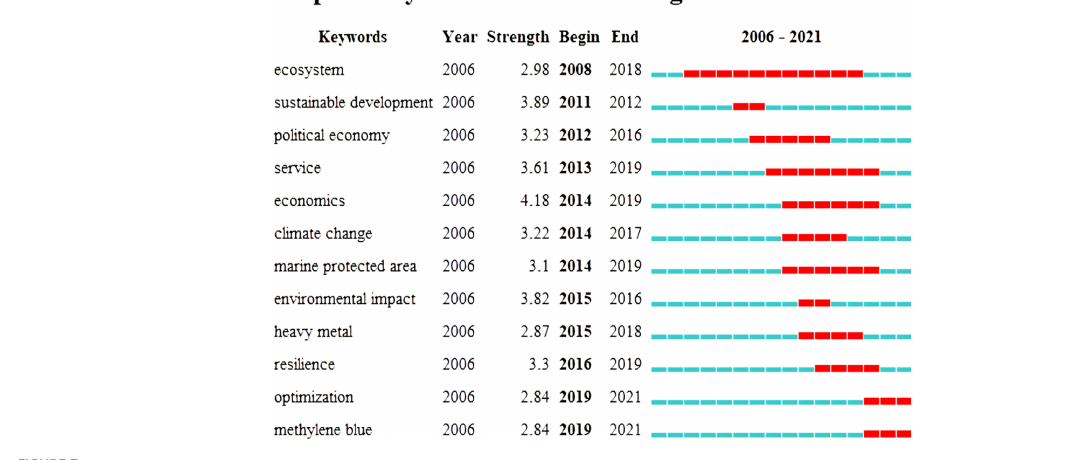
FIGURE 7 The knowledge graph of keywords with the strongest citation